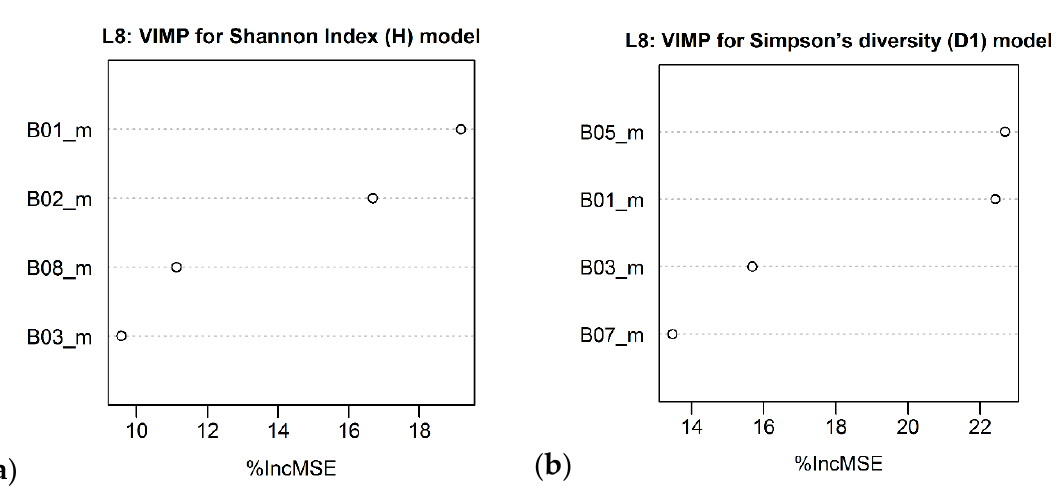
Figure 2. Importance of Landsat-8 OLI bands using the percentage increase in mean squared prediction error (%IncMSE) for ( a ) Shannon’s ( H’ ) and ( b ) Simpson’s diversity ( D1 ) indices. Higher %IncMSE indicates greater variable importance.